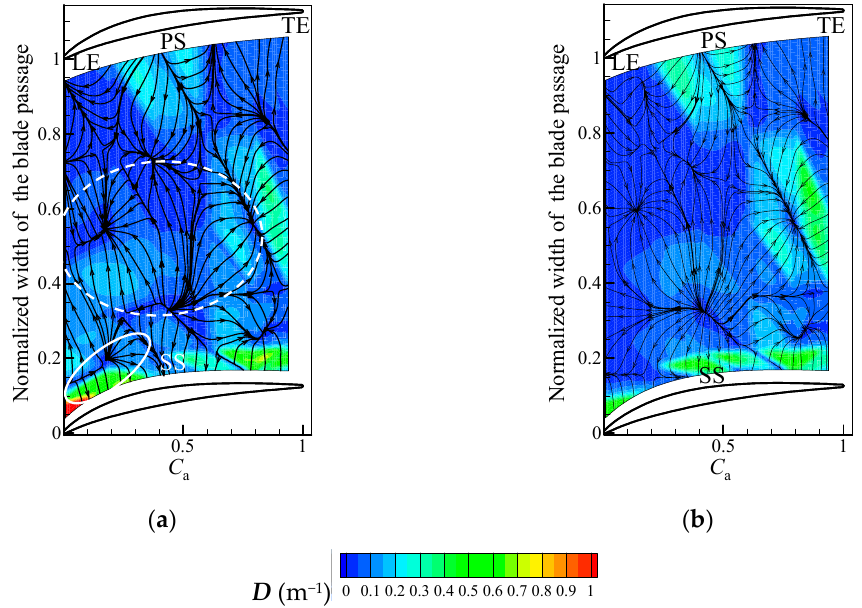
Figure 17. The distribution of D on the end wall surface. ( a ) ⎯ m = 0.89; ( b ) ⎯ m = 0.77.